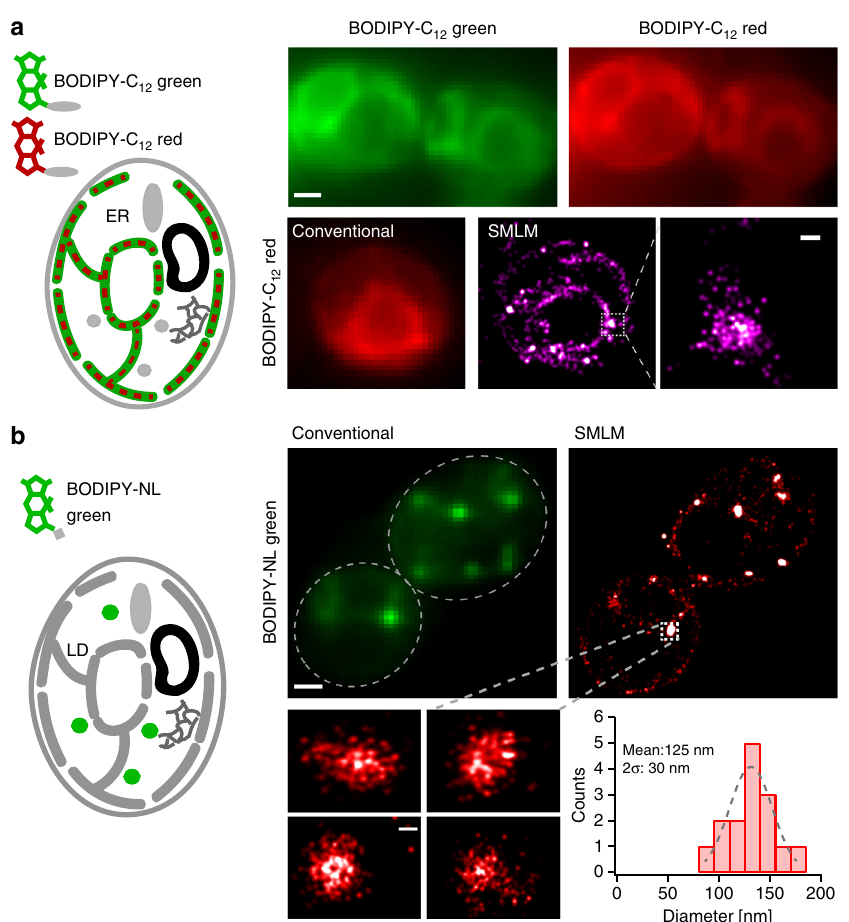
Fig. 3 General applicability of versatile BODIPY conjugates for multi-color SMLM. a Conventional images of BODIPY-C 12 green and BODIPY-C 12 red show co-localization of both fatty acid analogs (top). Conventional fl uorescence and super-resolution images of BODIPY-C 12 red (bottom). b Conventional fl uorescence and super-resolution images of LDs using BODIPY-NL. Zooms show super-resolution images of individual LDs that cannot be resolved with conventional fl uorescence microscopy. The quanti fi ed diameters of different LDs have a mean of 125 nm. Scale bar: 1 µ m, zoom: 100